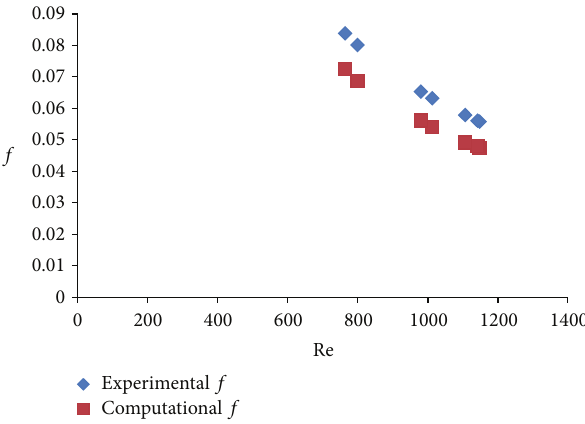
Figure 7: Friction factor versus Reynolds number for 0.87 mm ID- tube and 3% Al 2 O 3 -water nanofluid.